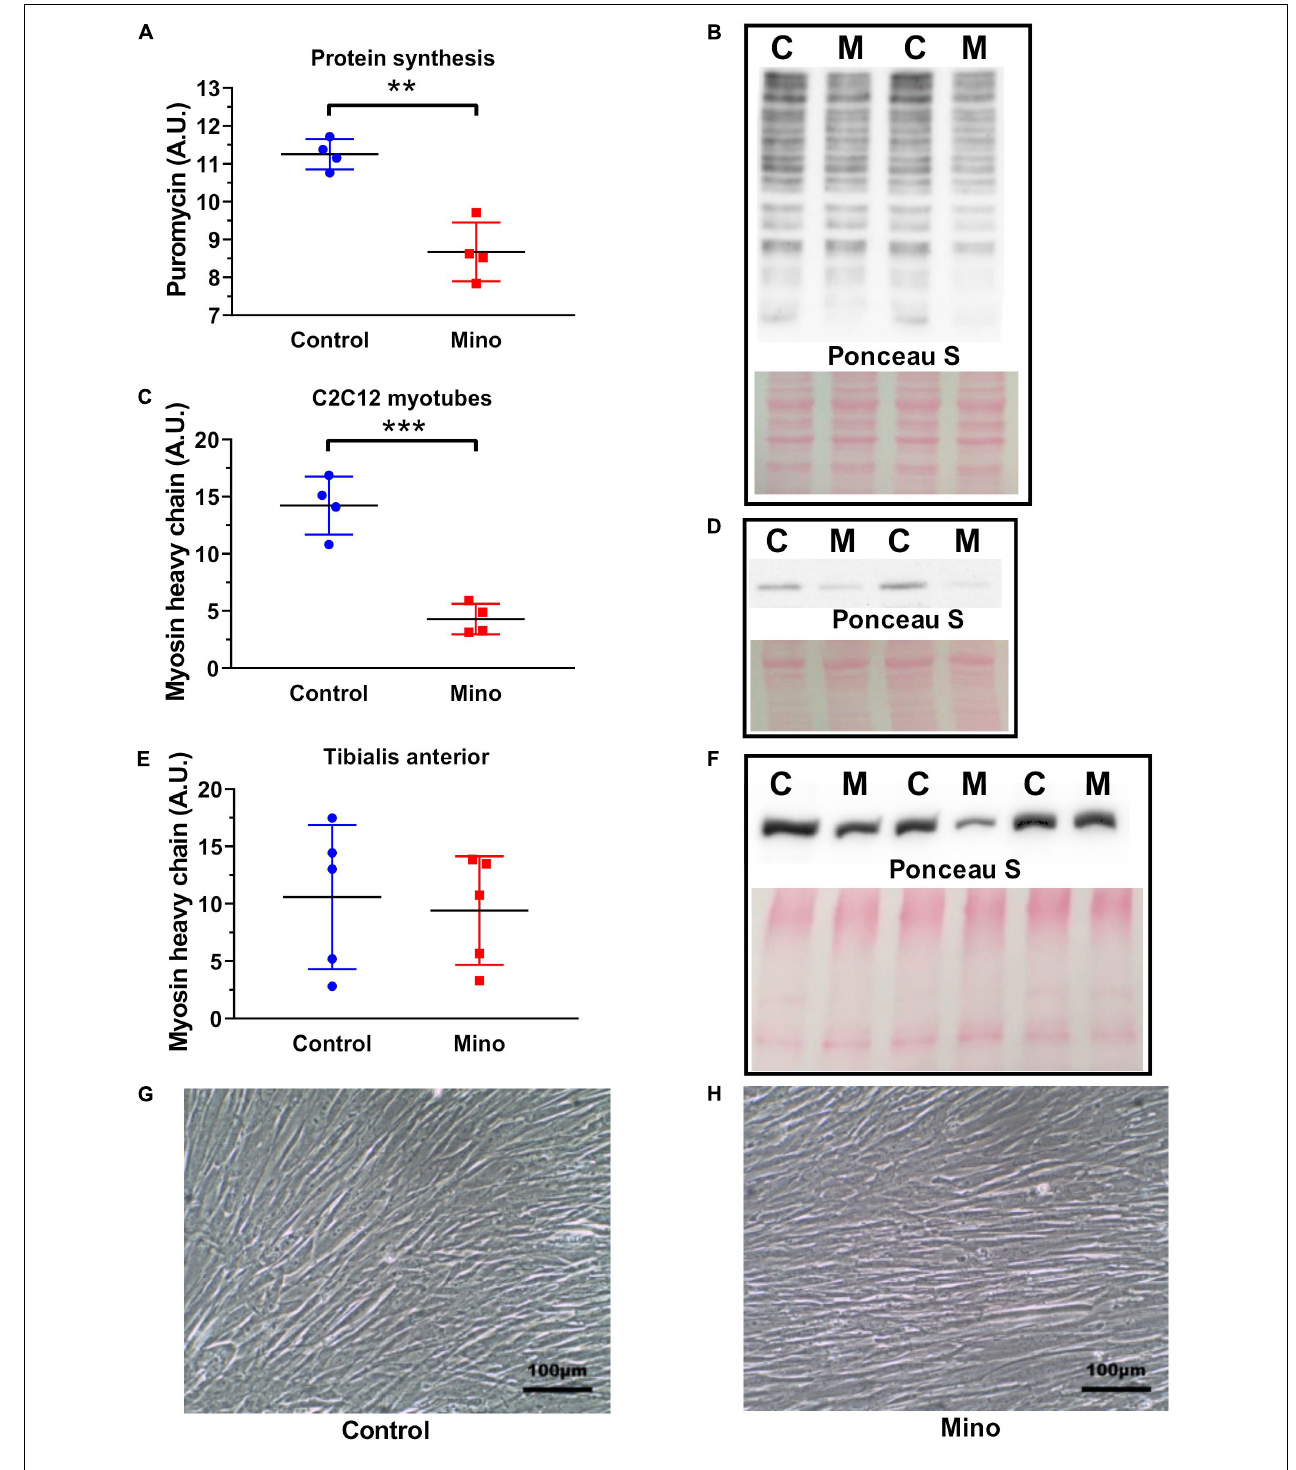
FIGURE 4 | Minocycline treatment (10 µ g/mL) for 48 h decreases protein synthesis and myosin heavy chain abundance in cultured C2C12 myotubes. (A,B) Protein synthesis was reduced by 23% with 48 h minocycline treatment (10 µ g/mL), as measured via puromycin incorporation in C2C12 myotubes. (C,D) Myosin heavy chain abundance was reduced with 48 h minocycline treatment (10 µ g/mL) in C2C12 myotubes. (E,F) Myosin heavy chain abundance was unchanged between minocycline treated TA muscles and untreated controls ( n = 5 from each group). (G,H) Light microscope images (X20 magnification) of C2C12 myotubes treated with minocycline. Scale bars have been included in the bottom right corner of images. n = 4 independent experiments for each unless specified. ** p < 0.01, *** p < 0.001 via unpaired t -tests. Values are mean ± SD.